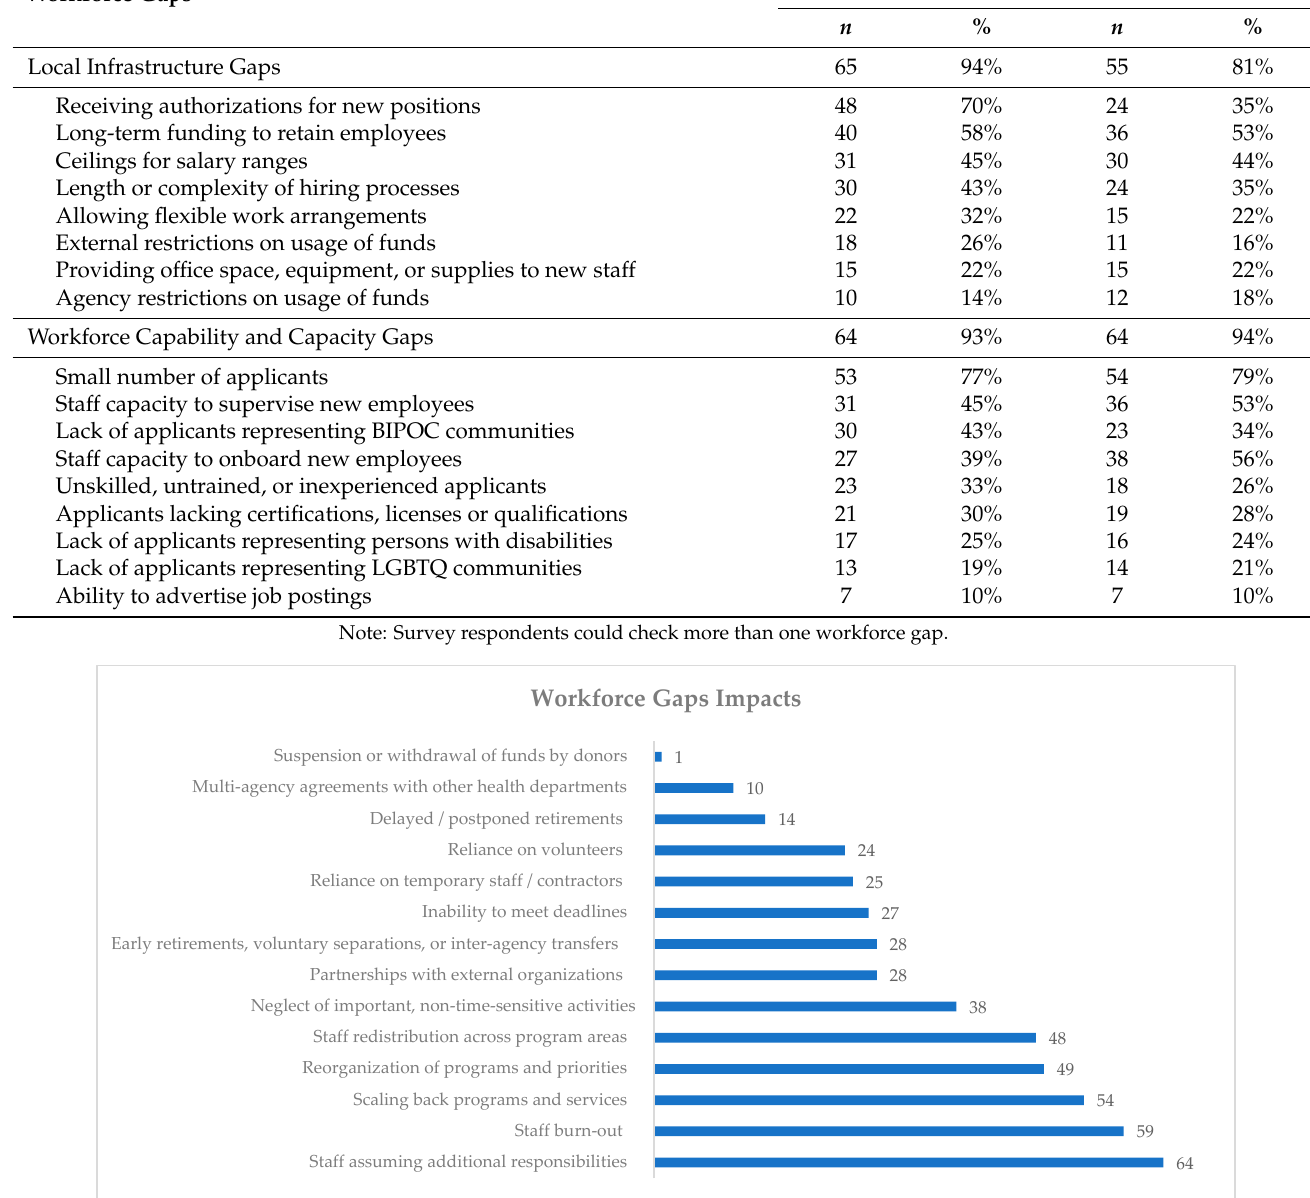
Figure 2. Workforce gaps impacts experienced by survey respondents’ agencies. ( n = 70). Note: Survey respondents could check more than one impact.